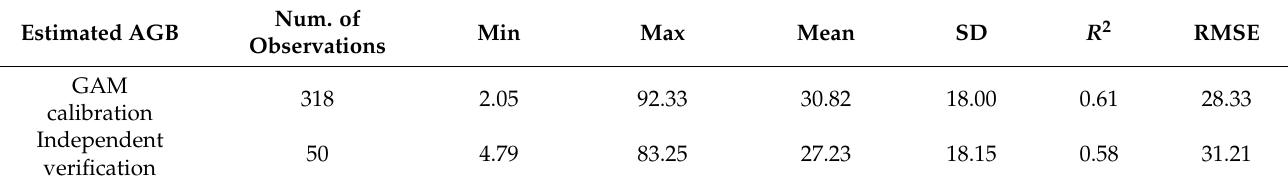
Table 10. Independent verification of the general model to estimate AGB (Mg ha − 1